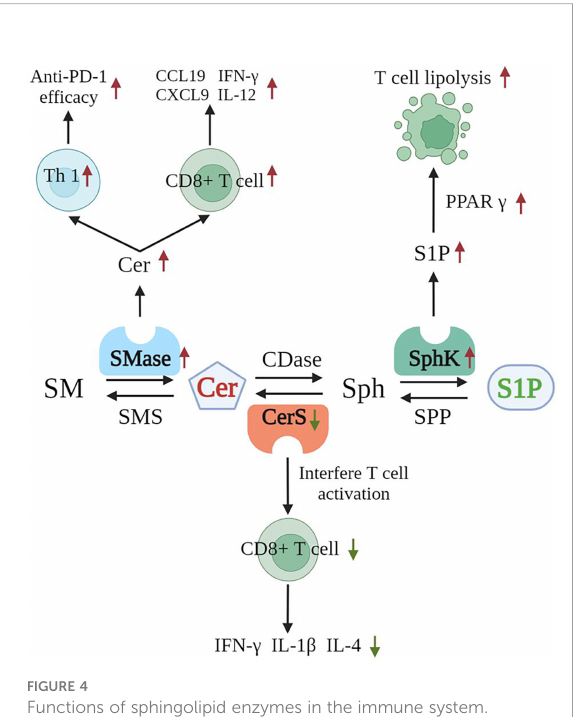
FIGURE 4 Functions of sphingolipid enzymes in the immune